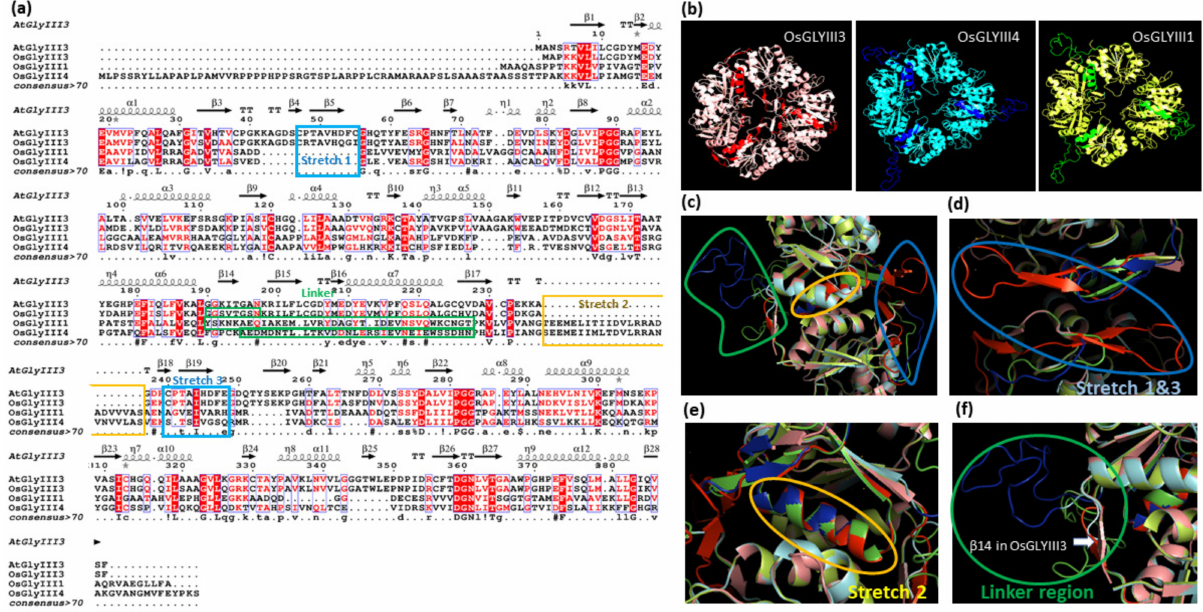
Figure 7. Structural differences in rice GLYIII proteins belonging to three clusters are indicative of their functional flexibility. ( a ) Sequence alignment and secondary structure information of rice OsGLYIII3, OsGLYIII4, and OsGLYIII1 proteins using ESpript3.0. ( b ) Homotrimeric structure of OsGLYIII3, 4 and 1 as modelled using SWISS-MODELLER. ( c ) Enlarged view showing regions of structural dissimilarity between the three proteins. Enlarged view showing region corresponding to ( d ) stretch 1 and 3, ( e ) stretch 2 and ( f ) linker region, in the aligned monomers of the three proteins. AtGLYIII3 was used as the template for both secondary and tertiary structure predictions. Structures were visualized in